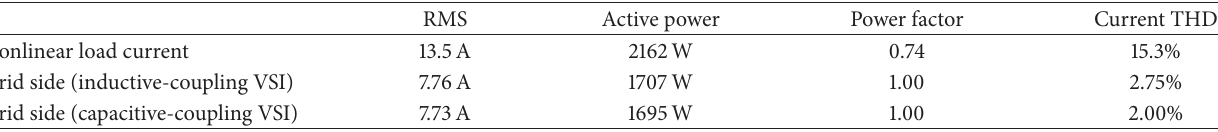
Table 5: Simulation results with harmonics